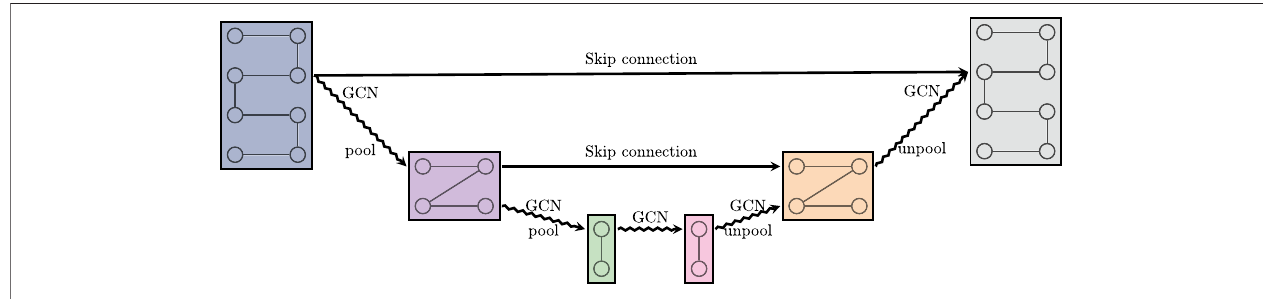
FIGURE3| AgraphU-net.GCNisde fi nedin(2.12).Poolandunpooldenotegraphcoarseningandre fi nement,respectively.Skipconnectiondenotesasummation of the respective feature